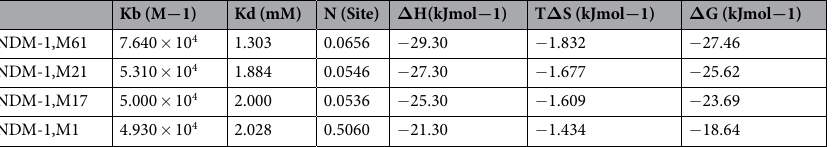
Table 8. Thermodynamic Parameters for the Binding of NDM-1 protein with M61, M21, M17, M1 respectively as Estimated by Isothermal Titration